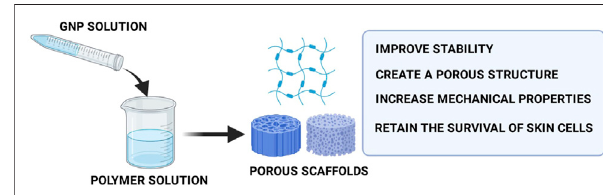
FIGURE 5 | Functions of GNP in scaffold fabrication. The addition of GNPintothescaffoldswillproduceporousscaffoldswithsuperiormechanical strength that causes shape-retaining